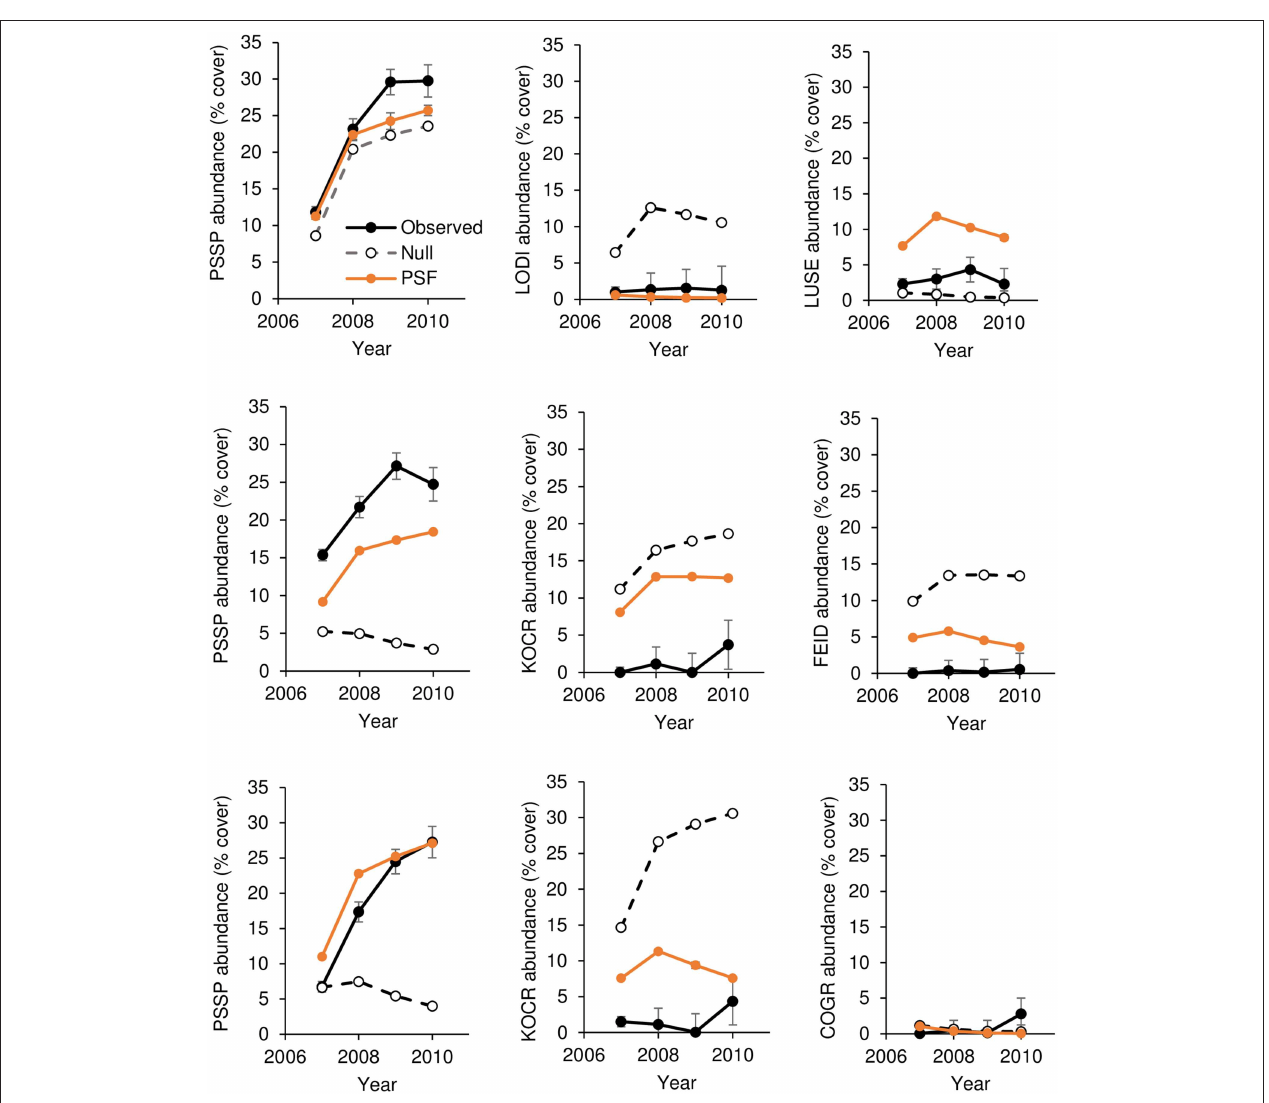
FIGURE 1 | Observed and predicted abundance of native plant species in three-species experimental plant communities grown for 4 years (2007–2010). Species in a row are from the same three-species community. Model predictions were made either with plant-soil feedback effects (PSF) or without plant-soil feedback effects (Null). PSSP, Pseudoroegneria spicata ; LODI, Lomatium dissectum ; LUSE, Lupinus sericeus ; COGR, Collomia grandifolia ; FEID, Festuca idahoensis ; KOCR, Koeleria cristata .